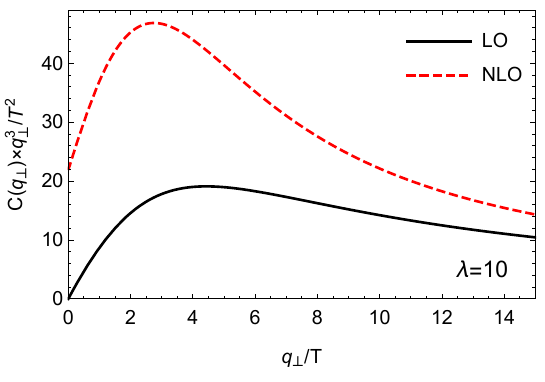
Figure 8 . C( q ⊥ ) q 3 ⊥ /T 2 as in figure 7, at larger coupling. ×